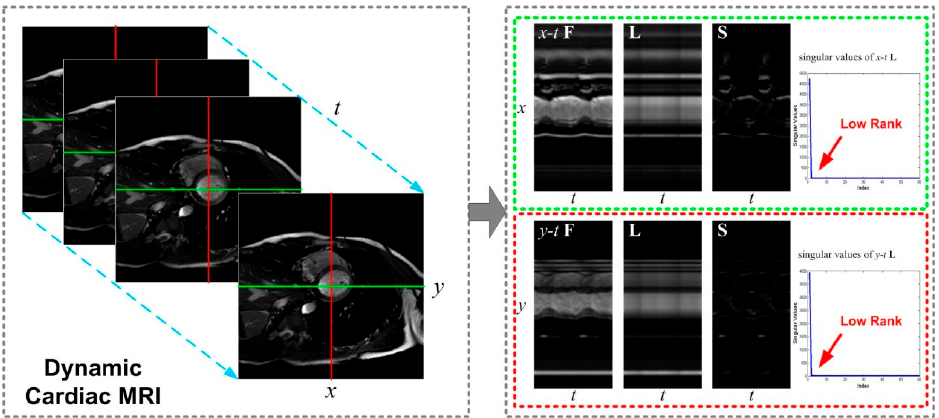
Figure 1. The low-rank plus sparse ( L + S ) decomposition of a fully sampled 2D axial cardiac MRI dataset. RPCA decomposes the x-t (or y - t ) temporal profiles (i.e., Casorati matrix) F into a low-rank component L and a sparse component S . The singular values of both x - t and y - t L tend to zero quickly as their index increases. S can be effectively represented using a sparsifying transform.